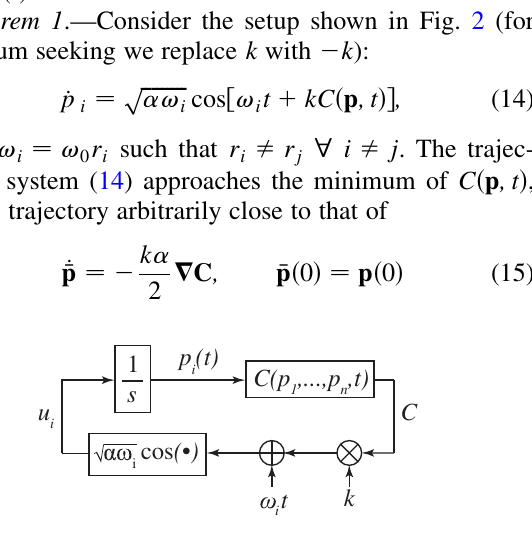
FIG. 2. Tuning of the i th component p i of p ¼ ð p 1 ; . . . ; p n Þ 2 R n . The symbol 1 denotes the Laplace transform of an integrator, s so that in the above diagram p i ð t Þ ¼ p i ð 0 Þ þ